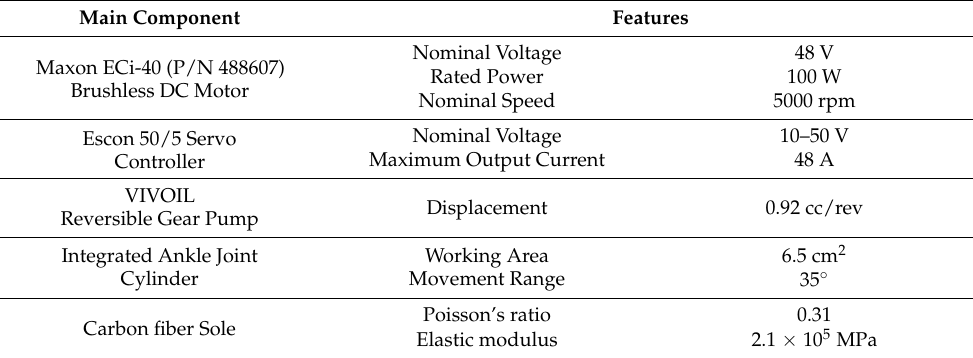
Figure 3. The ankle prosthesis. ( a ) The overall design of the prosthesis: 1: hydraulic cylinder; 2: shank link; 3: pressure sensors; 4: gear pump; 5: accumulator connector; 6: brushless DC motor; 7: spring slot; 8: connector; 9: heel spring; 10: displacement transducer; 11: sole. ( b ) The structure and the key dimension of the prosthesis. Table 5. Main components in the powered ankle